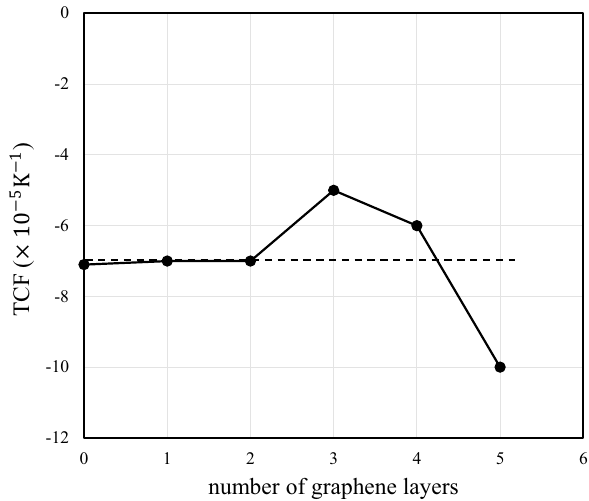
Figure 6. The thermal coefficients of the fundamental frequencies of SAW devices with mono-, bi-, tri-, tetra-, and penta-layers as functions of the number of layers. Here, the measurement accuracy of the TCF is ± 0.1 × 10 − 5 K − 1 .